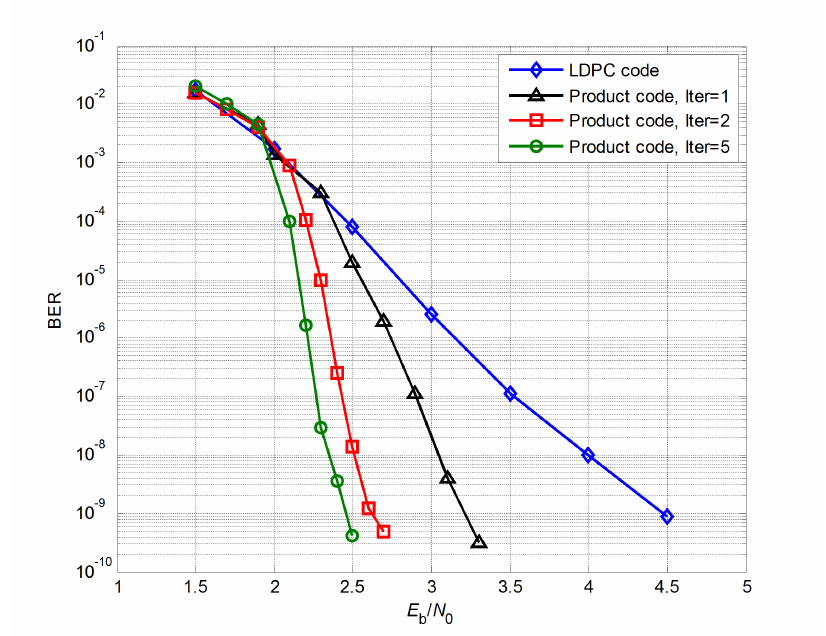
Figure 13. FPGA evaluation results of product codes with LDPC (576, 288) and Hamming (255, 247).